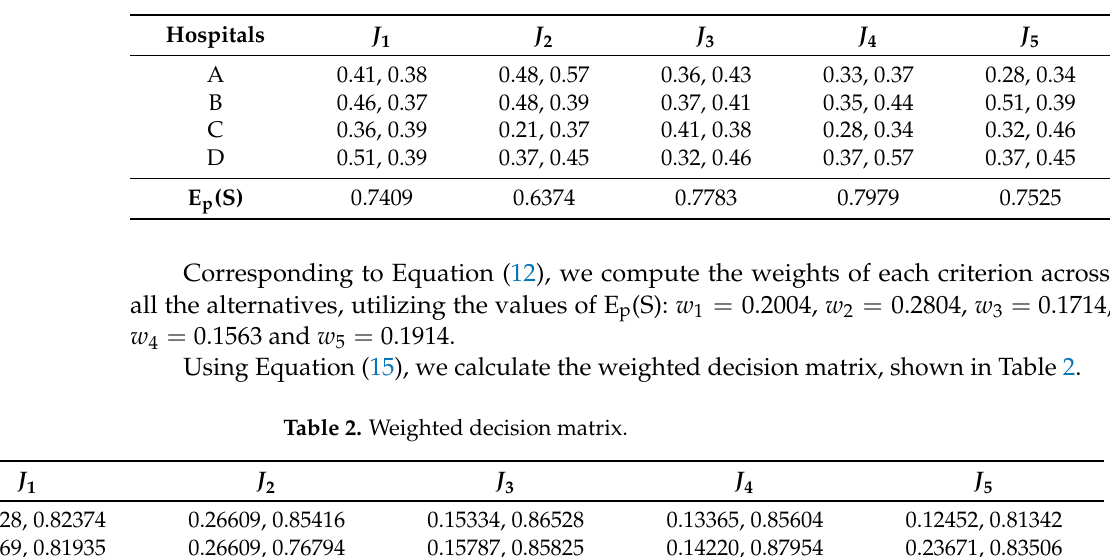
Table 1. Intuitionistic fuzzy decision matrix.